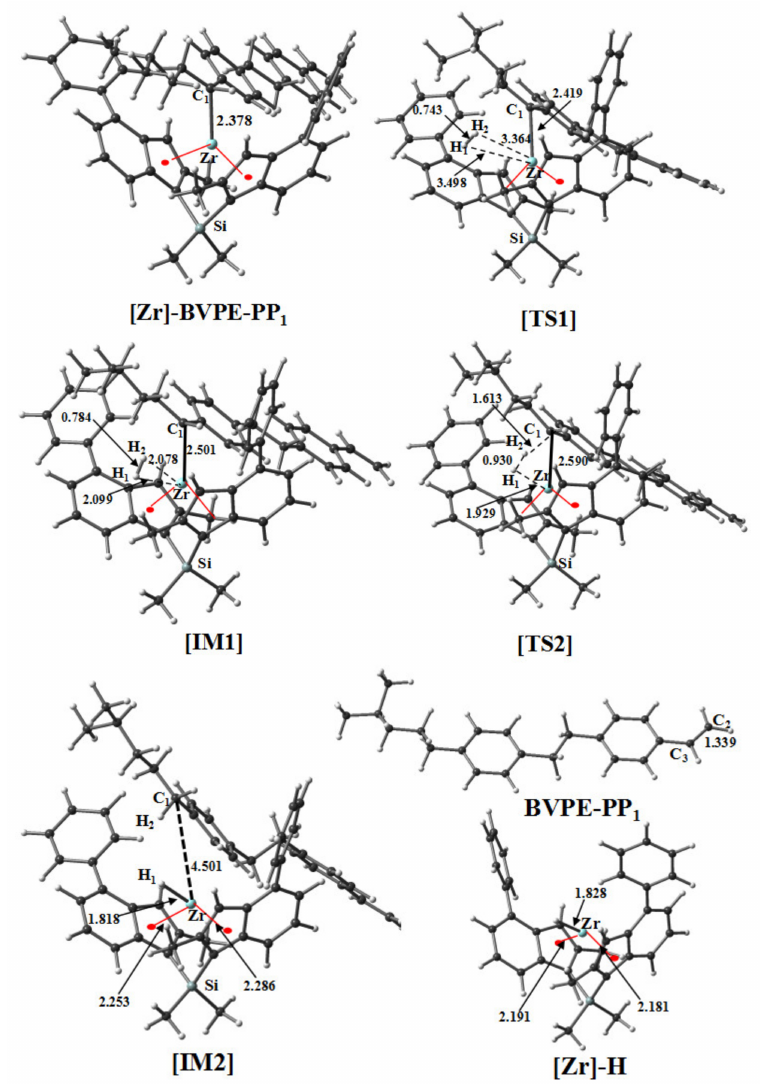
Figure 4. Optimized structures of key TSs and intermediates (IMs) in the BVPE reaction pathway shown in Figure 2. The key length is in